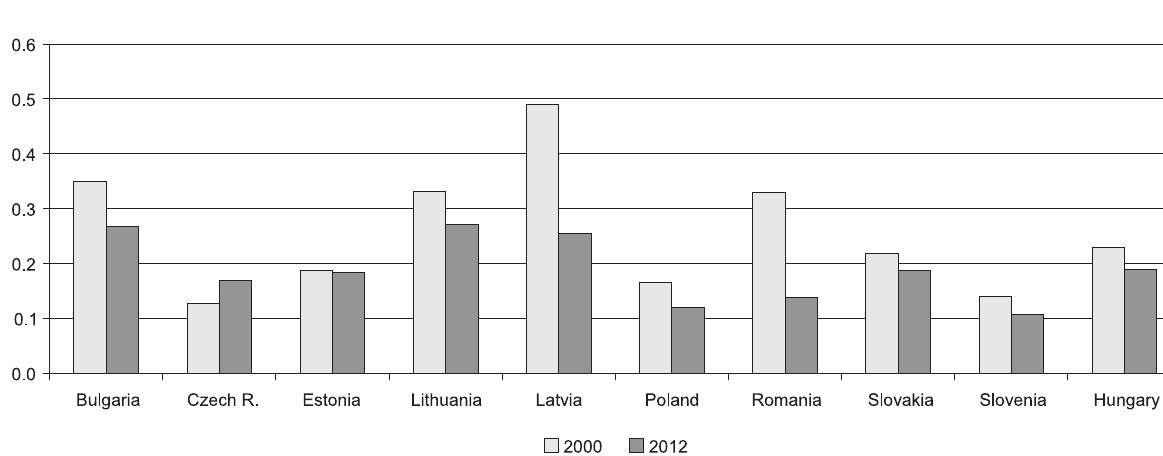
Fig. 5. Indicators of similarity between the commodity export structures of the post-communist countries and the EU-15, 2000 and 2012.